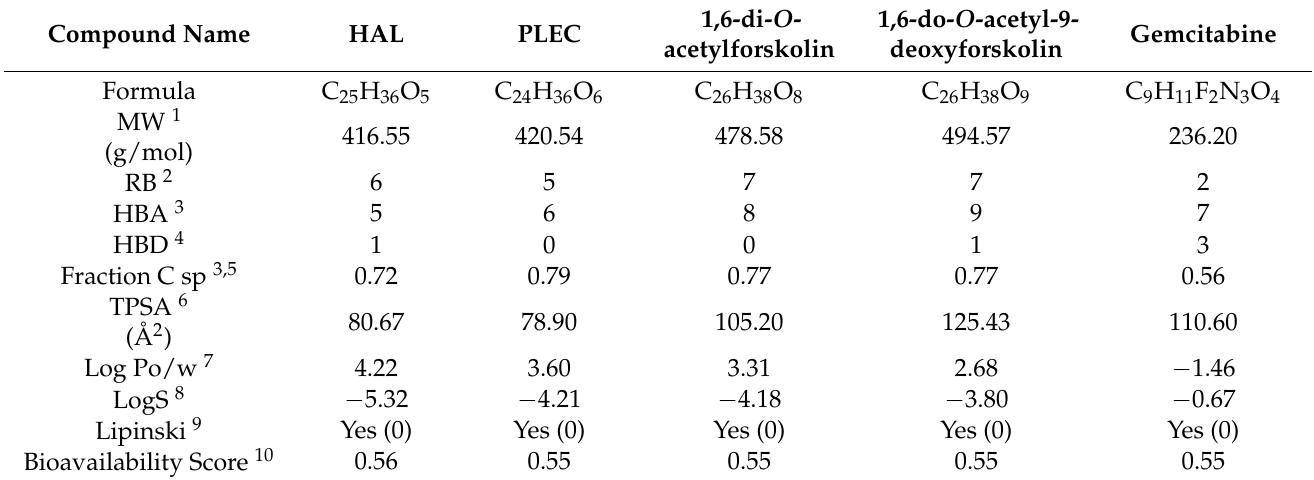
Table 1. Physicochemical properties, lipophilicity, solubility, bioavailability, and drug-likeness predictions for the plant-derived diterpenes and the positive control,